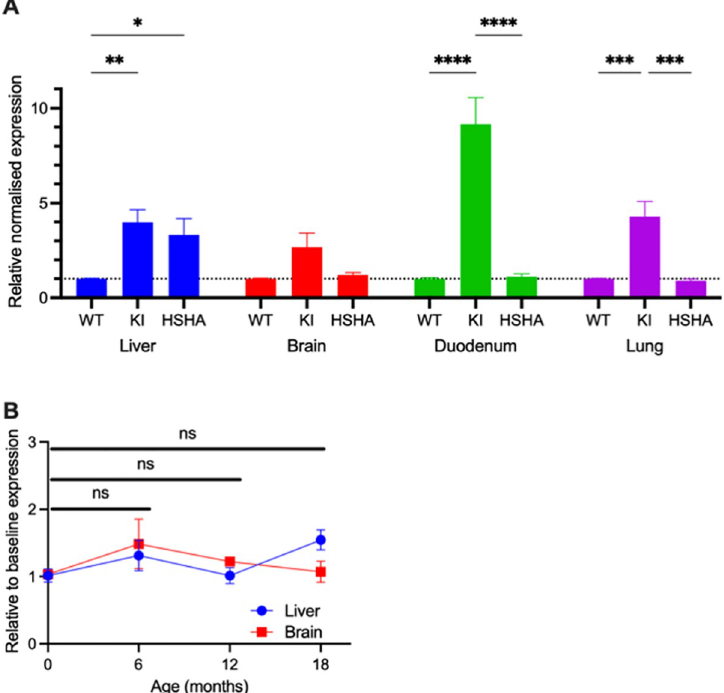
Fig 1. mRNA expression of human APP relative to reported gene Eef2. The APP qPCR assay is designed to only detect human APP using a locked nucleic acid approach. The assay was tested against WT cDNA isolated from WT mice, and no amplification was observed, indicating that the assay was specific to human APP sequence only. (A) Detection of qPCR signal demonstrates the expression of Human APP in mRNA. qPCR of RT-cDNA was performed in duplex with Eef2 (MGI: 95288) as an endogenous control. Expression of the read-through is arbitrarily set a value of 1, and then the relative expression level of APP following breeding to cre, either liver-specific Alb-cre (HSHA) or germline OzCre deletor (KI), is compared to it. Data are presented as mean ± SEM relative normalised expression ( n = 3). Two-way ANOVA followed by Fisher LSD post hoc multiple comparison was used to determine the statistical significance ( � p < 0.05, �� p < 0.01, ��� p < 0.001, ���� p < 0.0001). (B) Human APP mRNA expression was also measured with qPCR in liver and brain tissues at 6, 12, and 18 months of age. Data are presented as mean ± SEM